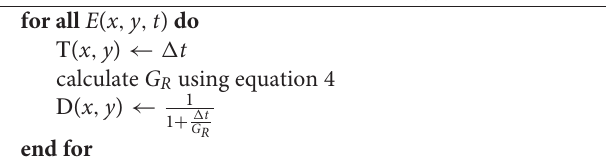
Algorithm 2 Local event-based tone mapping operators